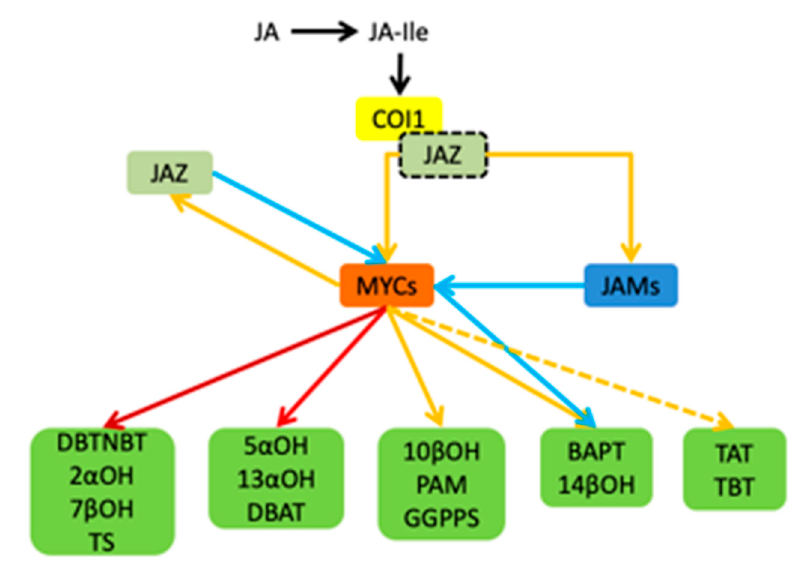
Figure 9. Schematic diagram of the jasmonic acid signalling pathway of T. media and its regulation of the paclitaxel biosynthesis pathway gene by the MYC transcription factor. The yellow solid line indicates that the upregulation or regulation is activated, the red solid line indicates a large upregulation, and the dark red solid line indicates a very large upregulation. The yellow dotted line indicates that there may be regulation, and the blue solid line indicates inhibition.